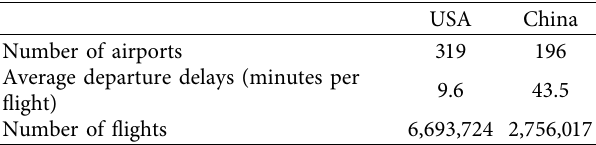
Table 2: General information on the US and China flight